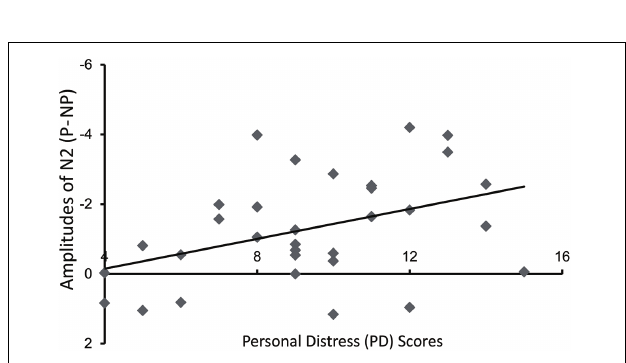
the scores in the PD subscale of IRI. The larger the difference between painful and non-painful conditions was the higher PD score the participant had. The PD scale was designed to